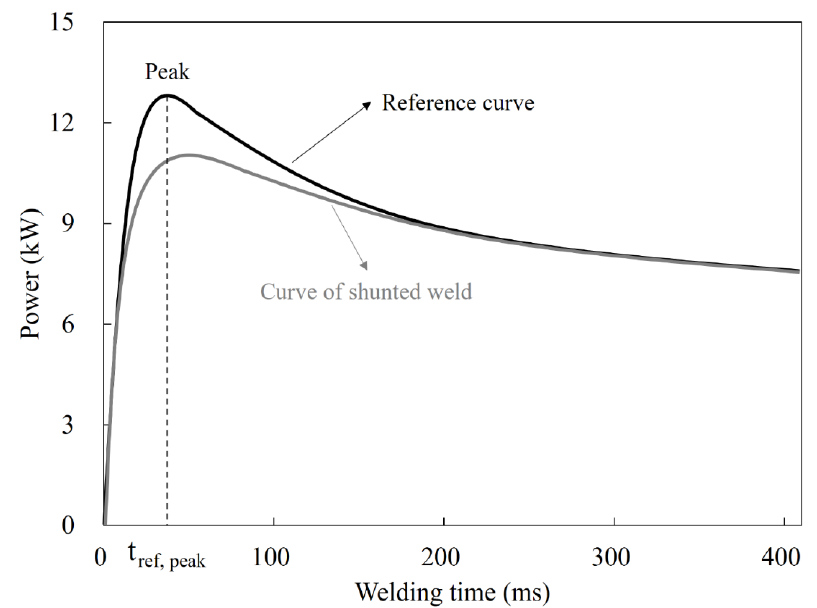
Figure 9. Heat input ratio parameter.